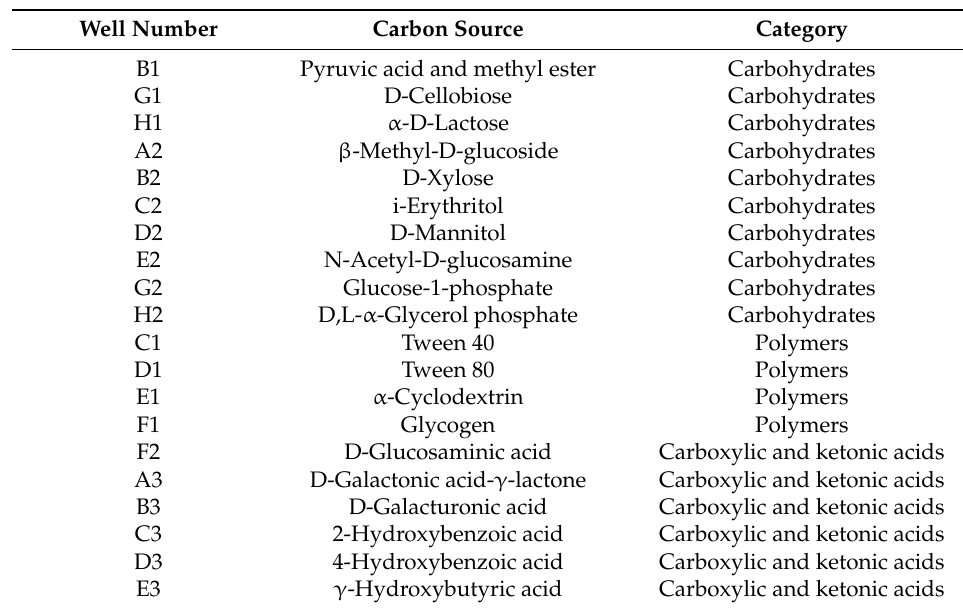
Figure 9. Heatmap of microorganism in various amendment treatments depending on carbon substrates in Biolog EcoPlate. Explanation: A1 to H4 see Table 5. (CTR: control, B: bentonite, AC: activated carbon, CS: cornstarch). Table 5. Biolog Ecoplate TM carbon source substrate category